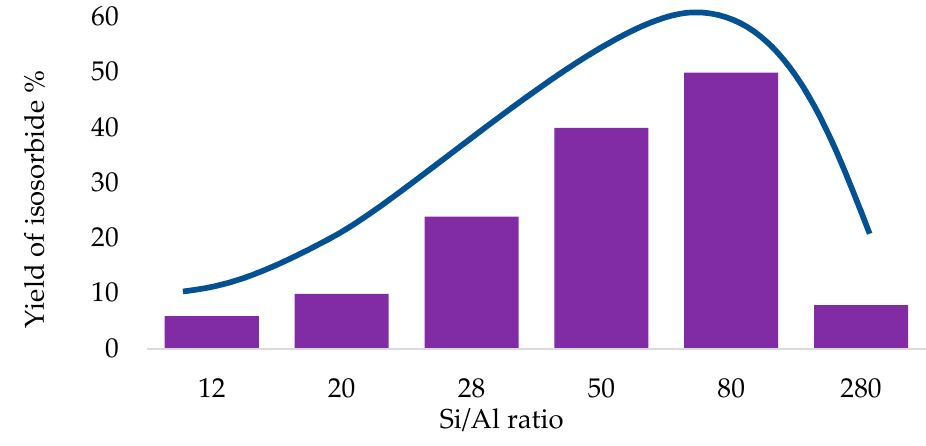
Figure 15. Volcano plot for isosorbide yield vs Si/Al ratio.